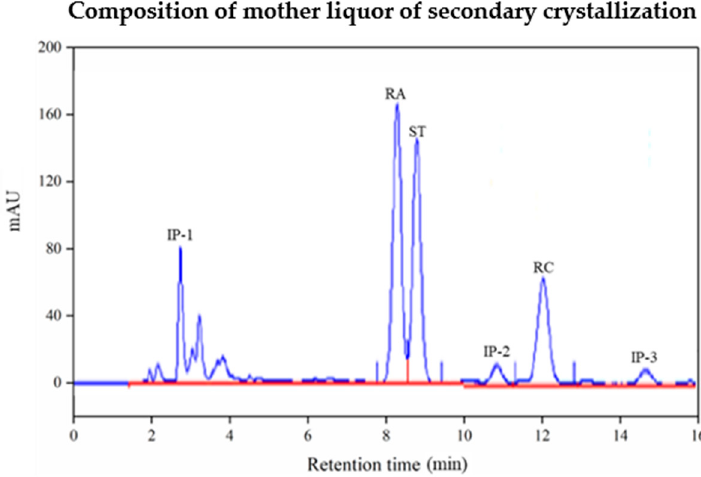
Figure 8. HPLC chromatogram of the liquid phase after second crystallization at 210 nm wavelengths.